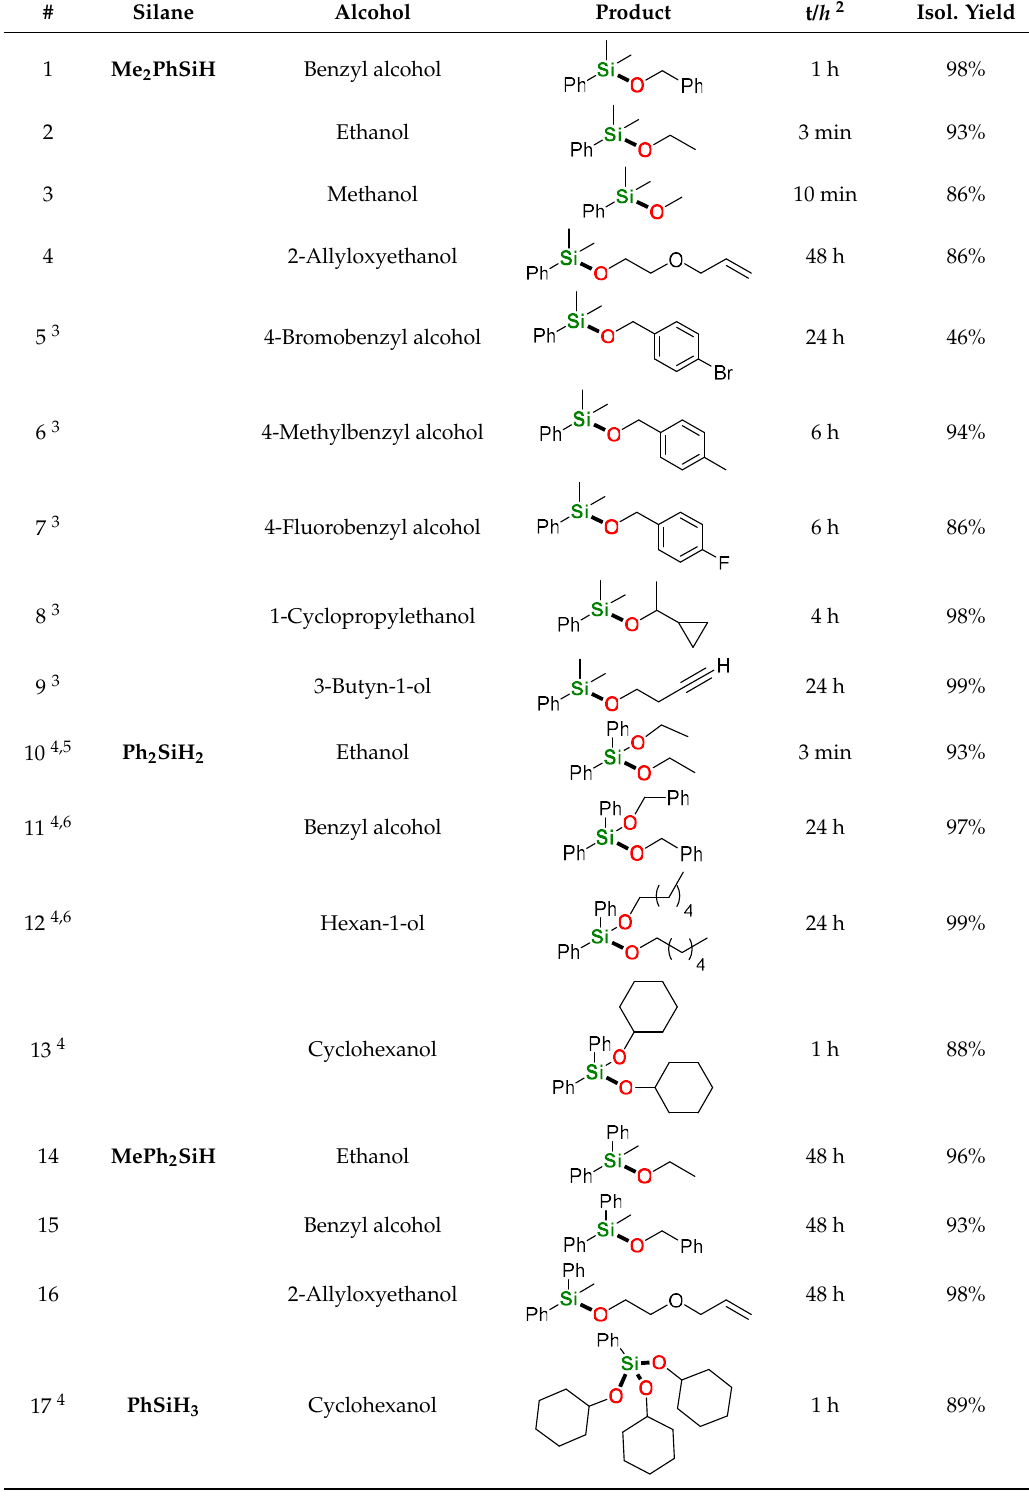
Table 2. Substrate scope of NaHB( s -Bu) 3— promoted dehydrogenative coupling of silanes with alcohols 1 .